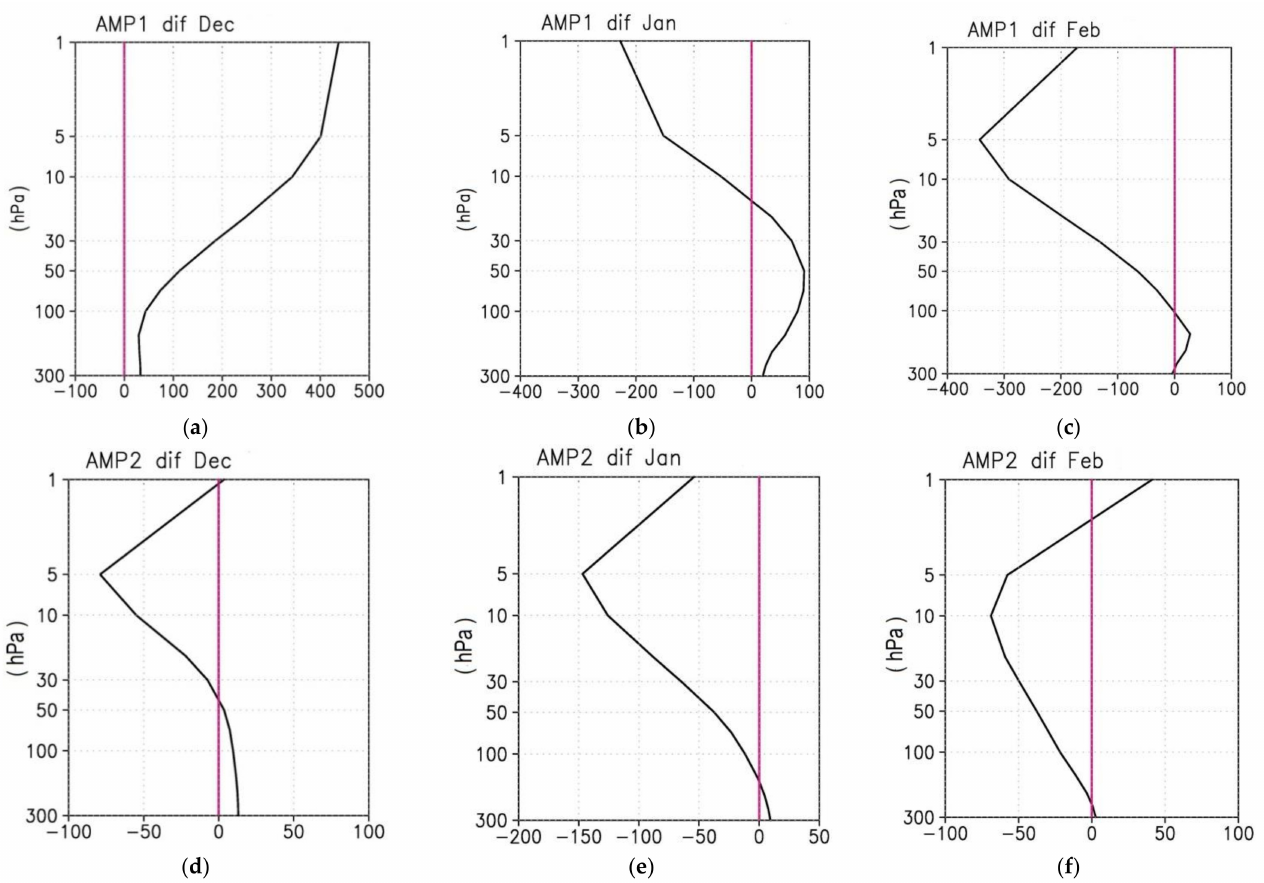
Figure 8. Difference in amplitude of (gpm) wave number 1 and 2 averaged over 45 ◦ N–75 ◦ N in December ( a , d ), January ( b , e ) and February ( c , f ) between the “warm” and “cold”